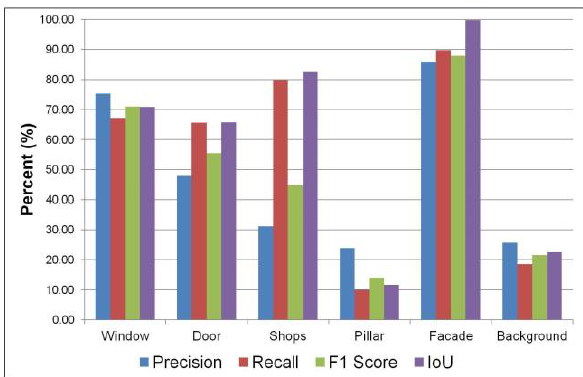
Figure 7. Bar chart illustrating the precision, recall, F1 score, and intersection over union (IoU) of each